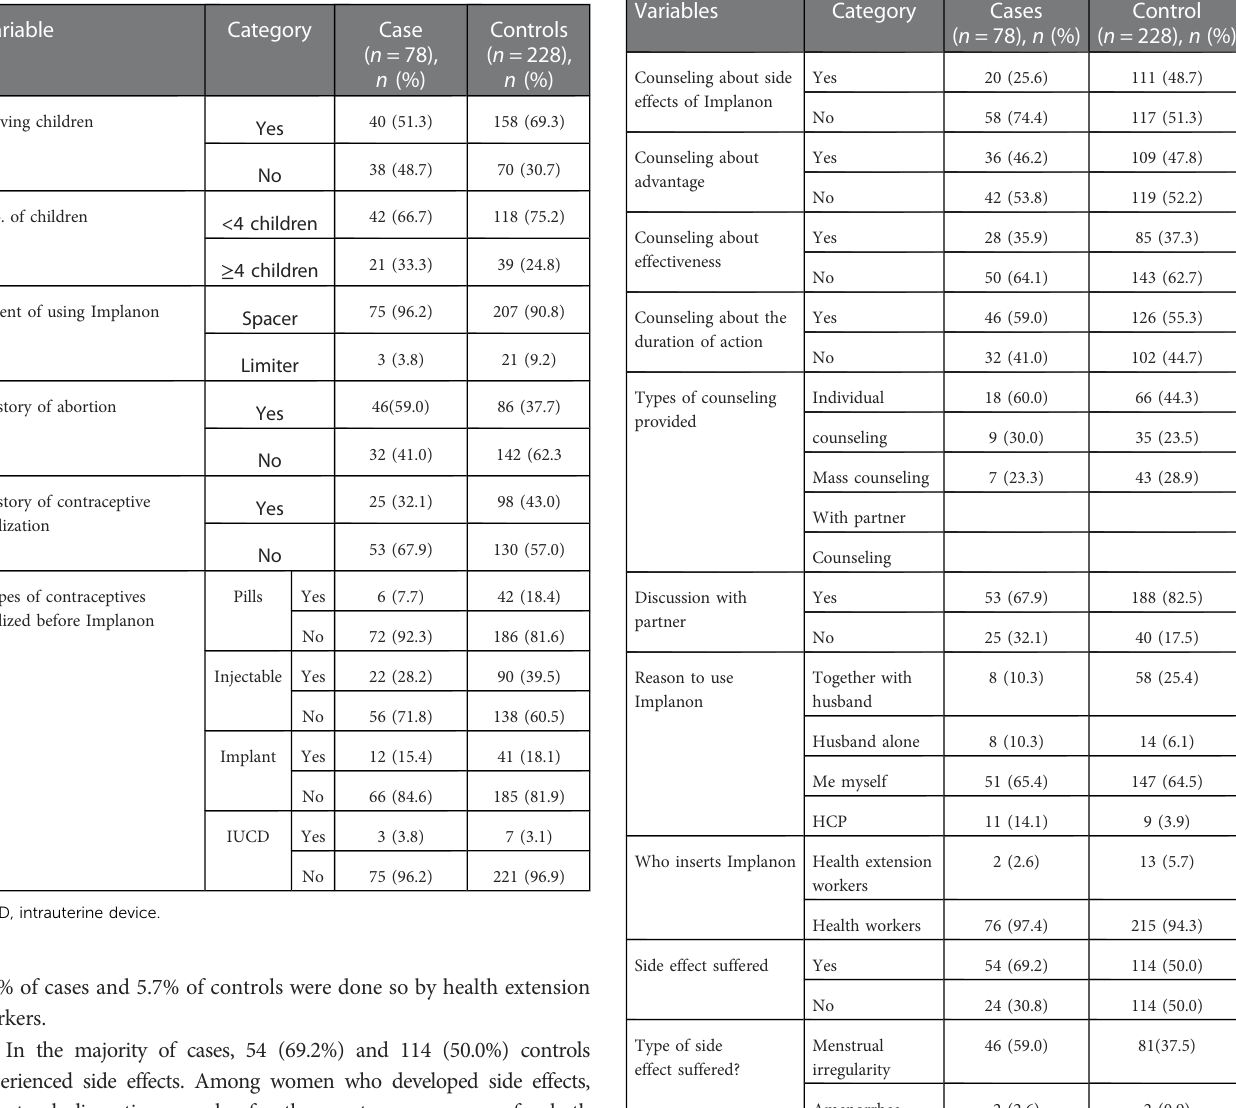
TABLE 2 Obstetric and gynecological characteristics of study participants among women who discontinued Implanon in Debre Berhan town, Northeast Ethiopia,